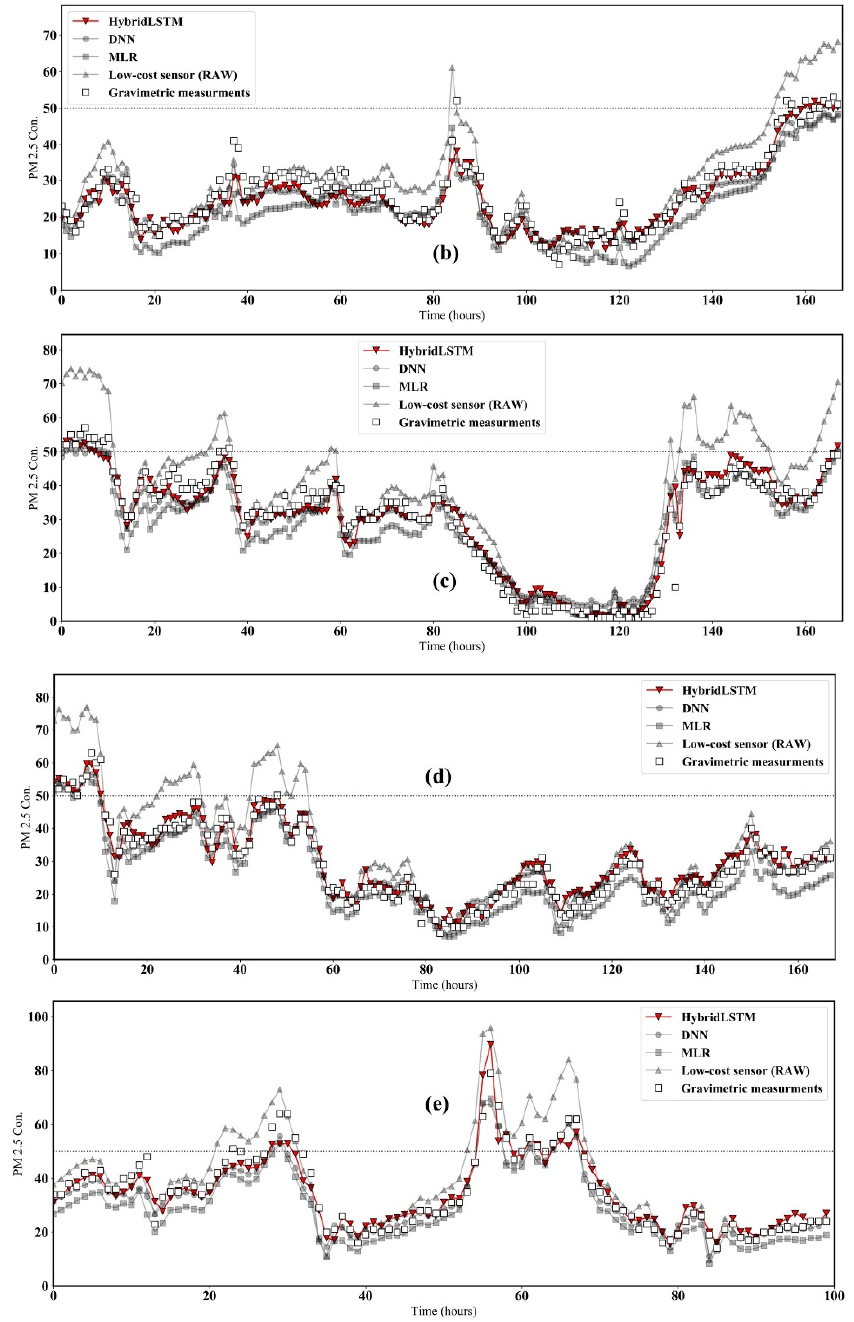
Figure 9. Results of time-series comparison results for the HybridLSTM, DNN, MLR and raw data versus gravimetric measurements at 1-week intervals; ( a ) 1, ( b ) 2, ( c ) 3, ( d ) 4 and ( e ) 5 weeks. The dotted line represents the high PM2.5 concentrations. We tested the calibration performance using datasets collected at 1-week intervals. A total of five sections were used (1, 2, 3, 4 and 5